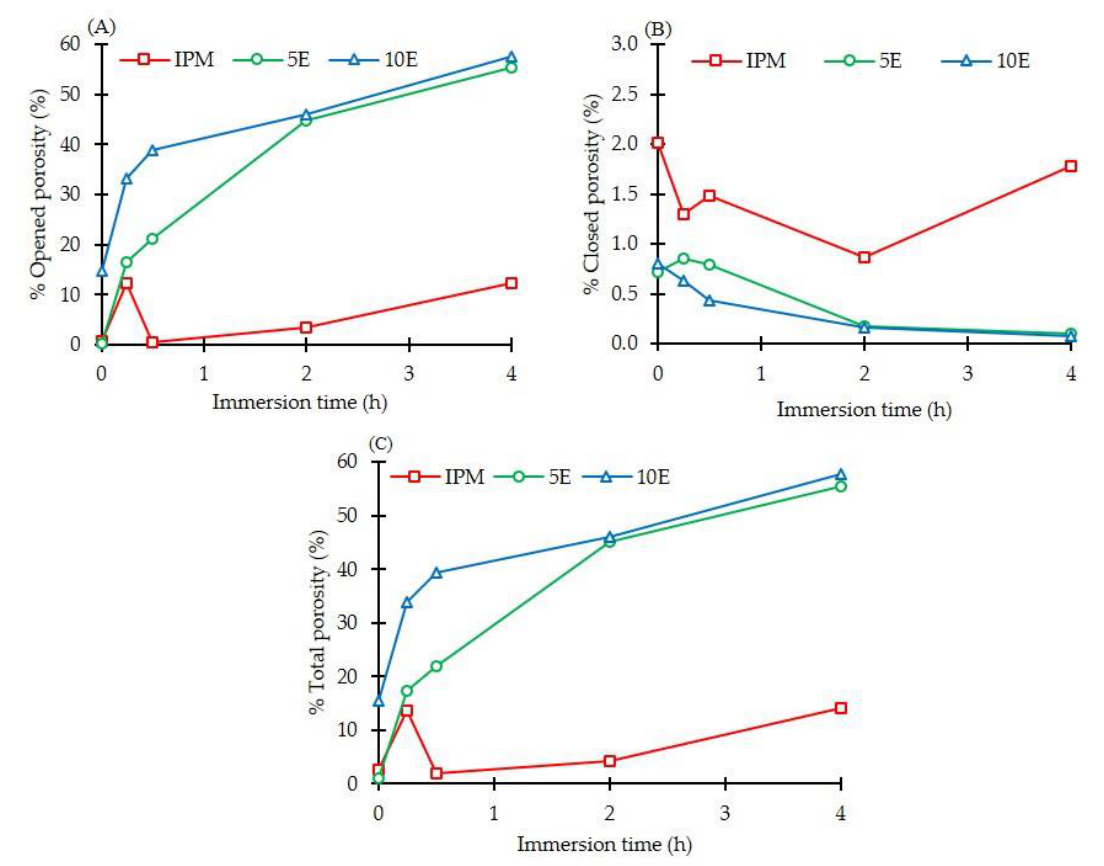
Figure 8. ( A ) Opened, ( B ) closed and ( C ) total porosities of IBU-P407 effervescent matrix tablets in pH-changed media at various immersion times.